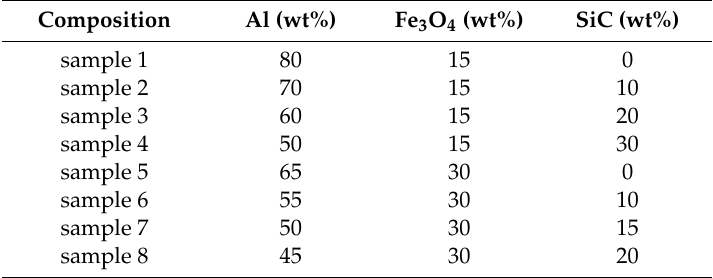
Table 1. Di ff erent compositions of aluminum, ferrous ferric oxide, and silicon carbide. Composition Al